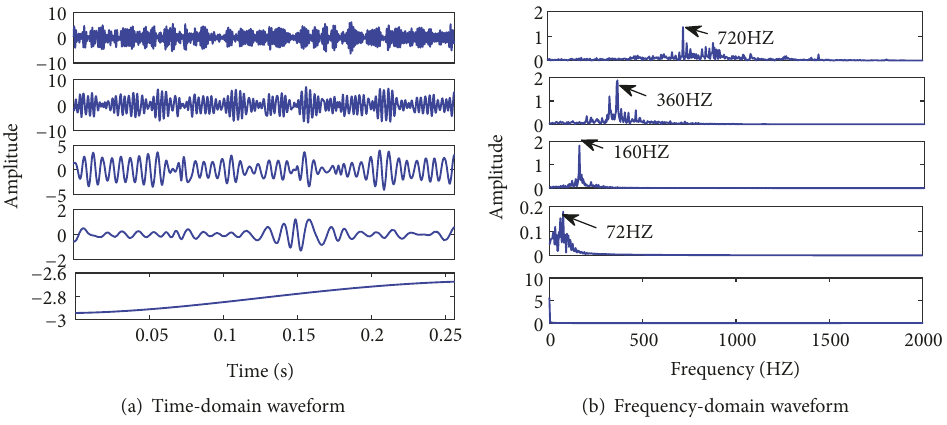
Figure 20: Decomposition results obtained by improved ELMD.